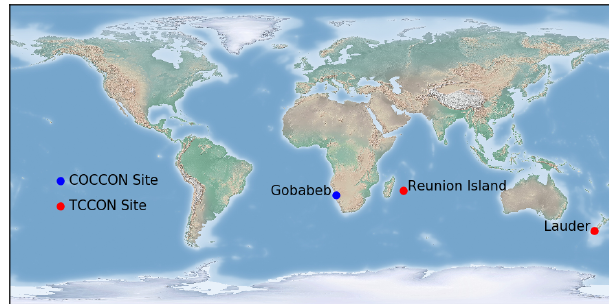
Figure 2. Global map showing the COCCON Gobabeb, TCCON Réunion Island and Lauder sites used in this